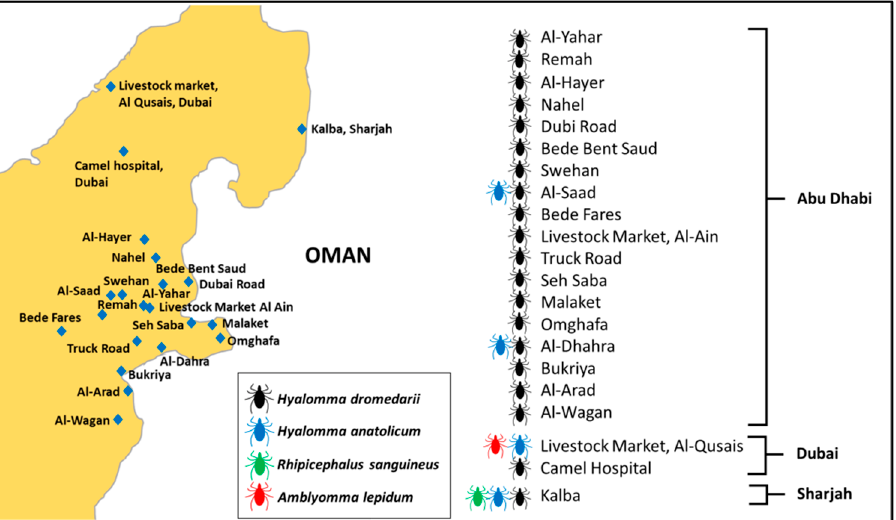
Figure 1. Tick collection sites and distribution of tick species on livestock in the study area, in 2019, 2020, and 2021, in the United Arab